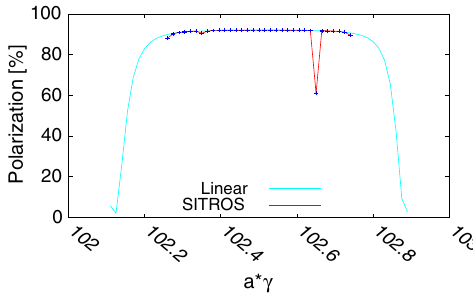
FIG. 5. Polarization vs. spin tune after orbit is corrected by using all 1096 correctors with δ Q y ¼ 200 μ m, w = o BPMs errors and in presence of 4 wigglers with B þ ¼ 0 . 7 T. 60 ° = 60 °